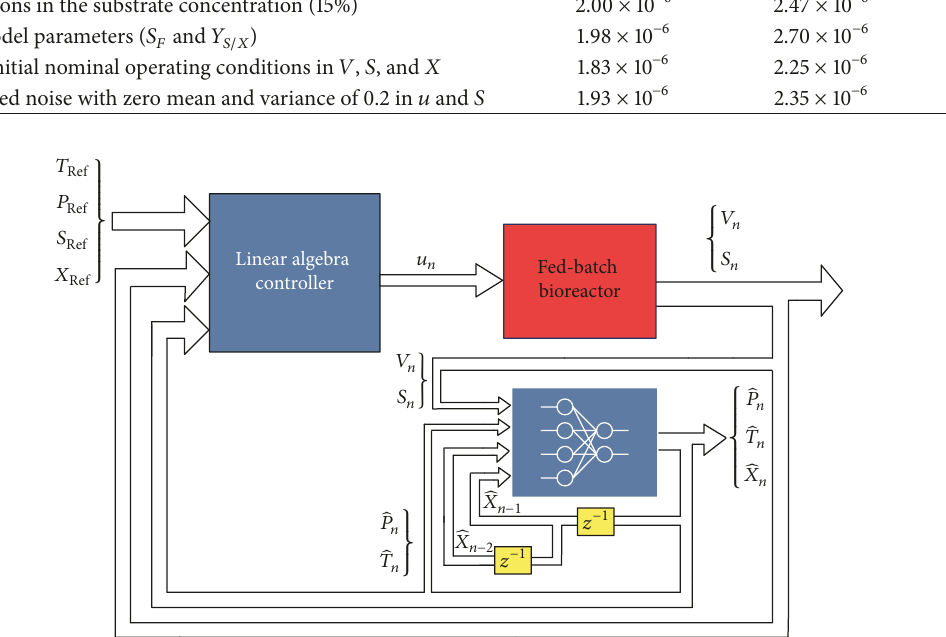
Figure 1: The proposed closed-loop control architecture: the linear algebra-based controller and the Radial Basis Function (RBF) neural network